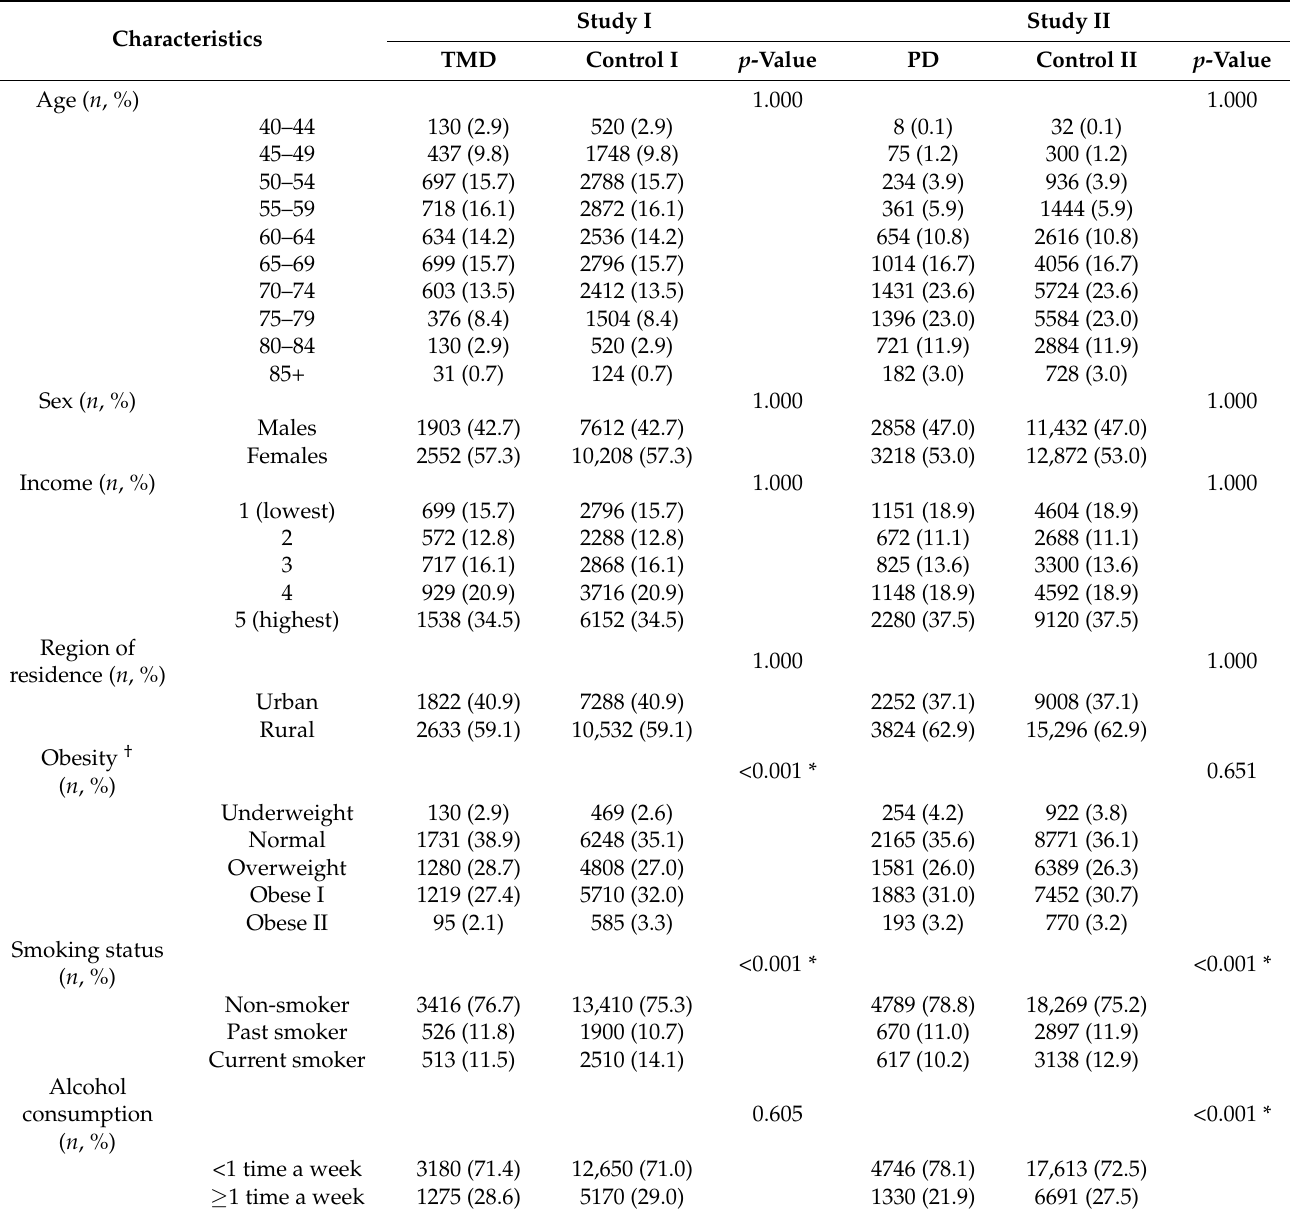
Table 1. General characteristics of the